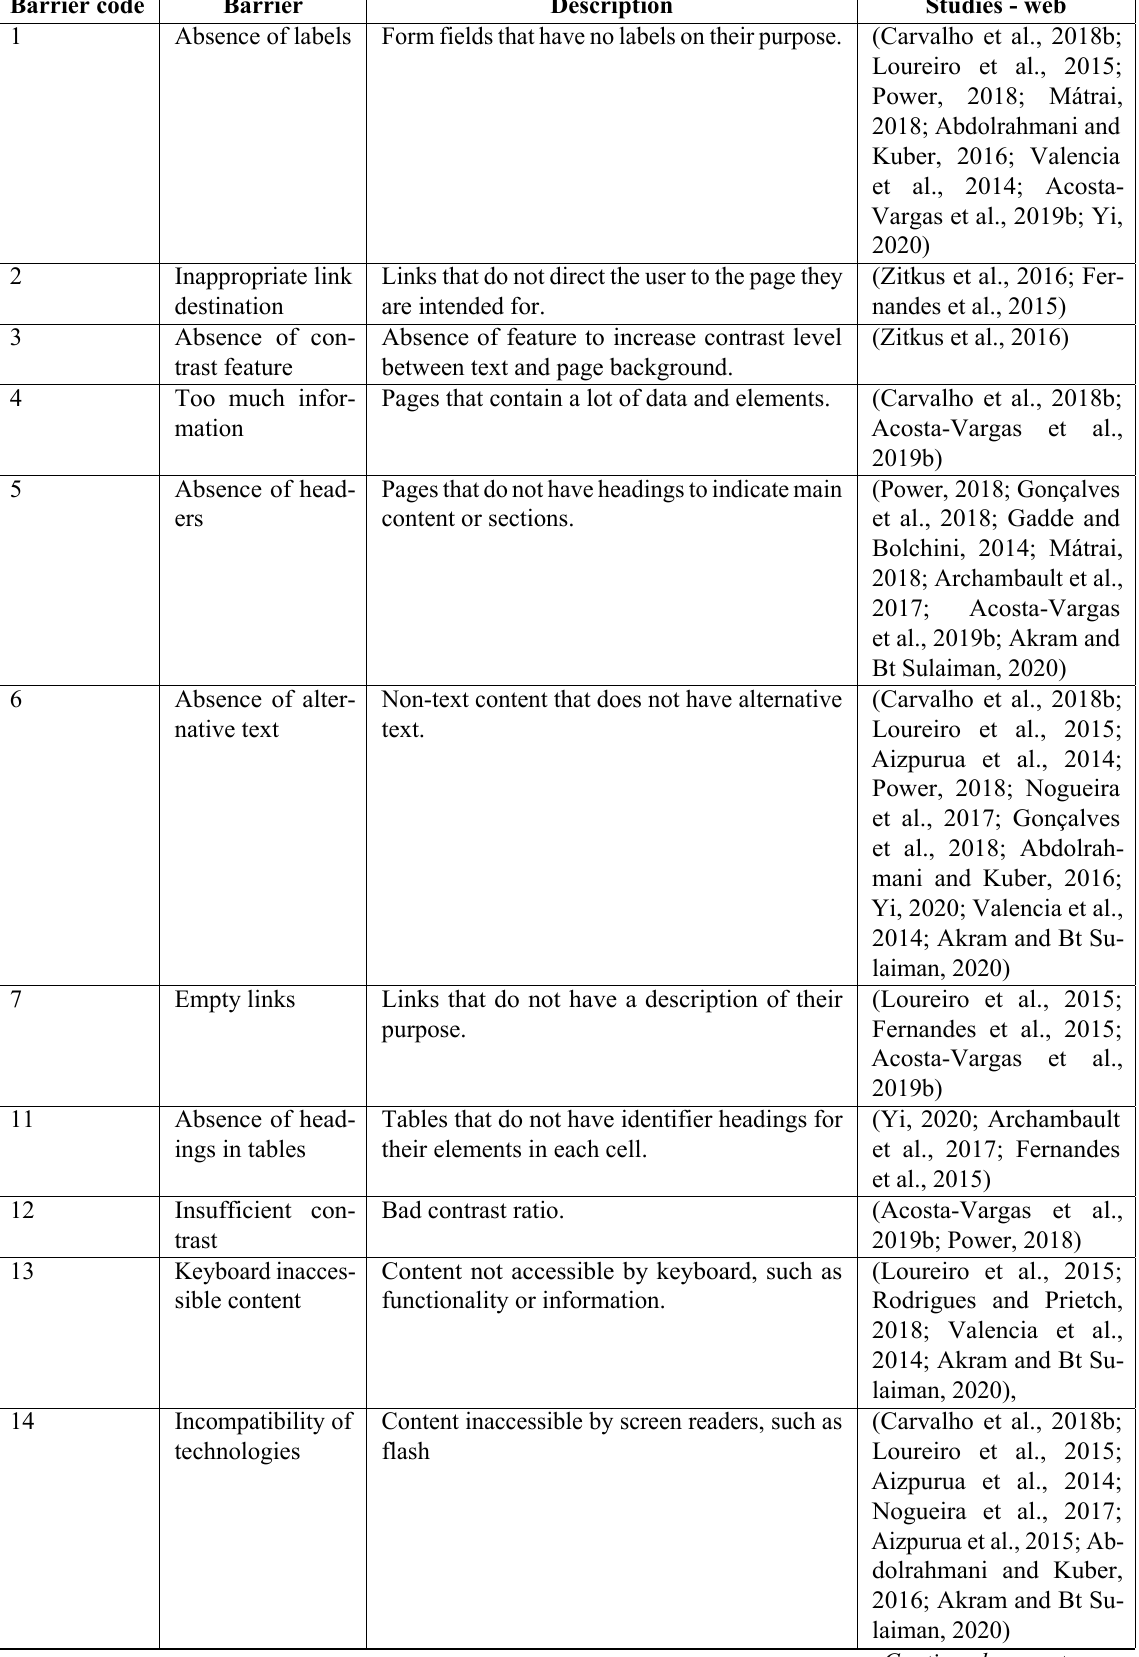
Table 14. Accessibility barriers encountered on websites by user